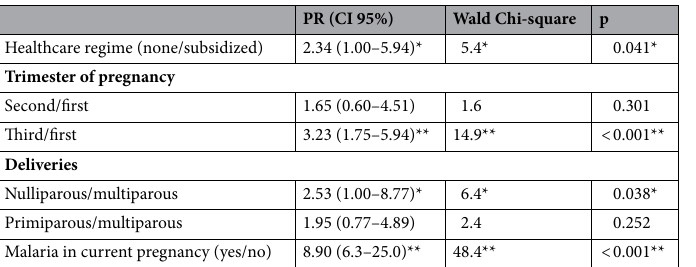
Table 3. Multivariable generalized linear model to identify potential explanatory factors for the frequency of gestational malaria. *p < 0.05. **p < 0.01. PR Prevalence ratio, 95% CI 95% Confidence interval.